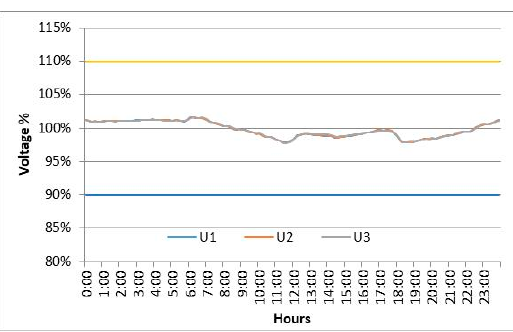
Figure 12. Comparison of the variation of the tension in steady state before the installation of the experimental system. Energies 2018 , 11 , x FOR PEER REVIEW